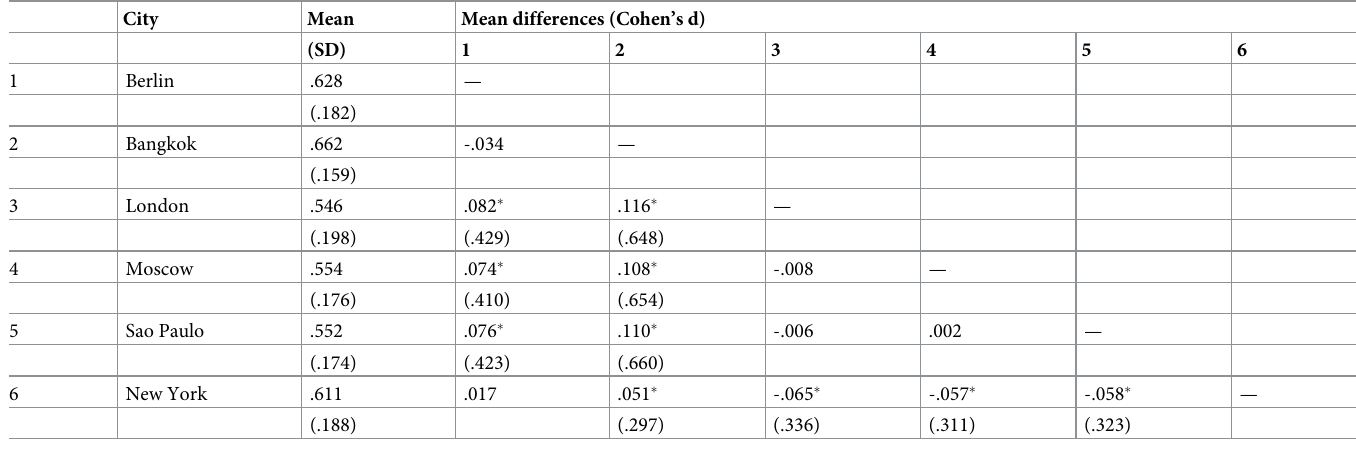
Table 2. Post hoc results for face-ism index differences by